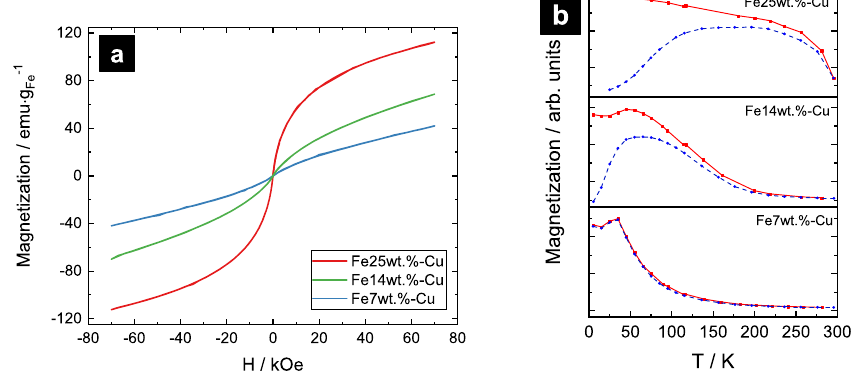
Figure 6. ( a ) magnetization versus applied field for Fe-Cu samples measured at 300 K. Saturation is not achieved, even at the highest applied field; ( b ) ZFC-FC for Fe-Cu samples at 50 Oe. Splitting is not pronounced for Fe7wt.%-Cu. For Fe7wt.%-Cu and Fe14wt.%-Cu a cusp at the FC-curve is found.